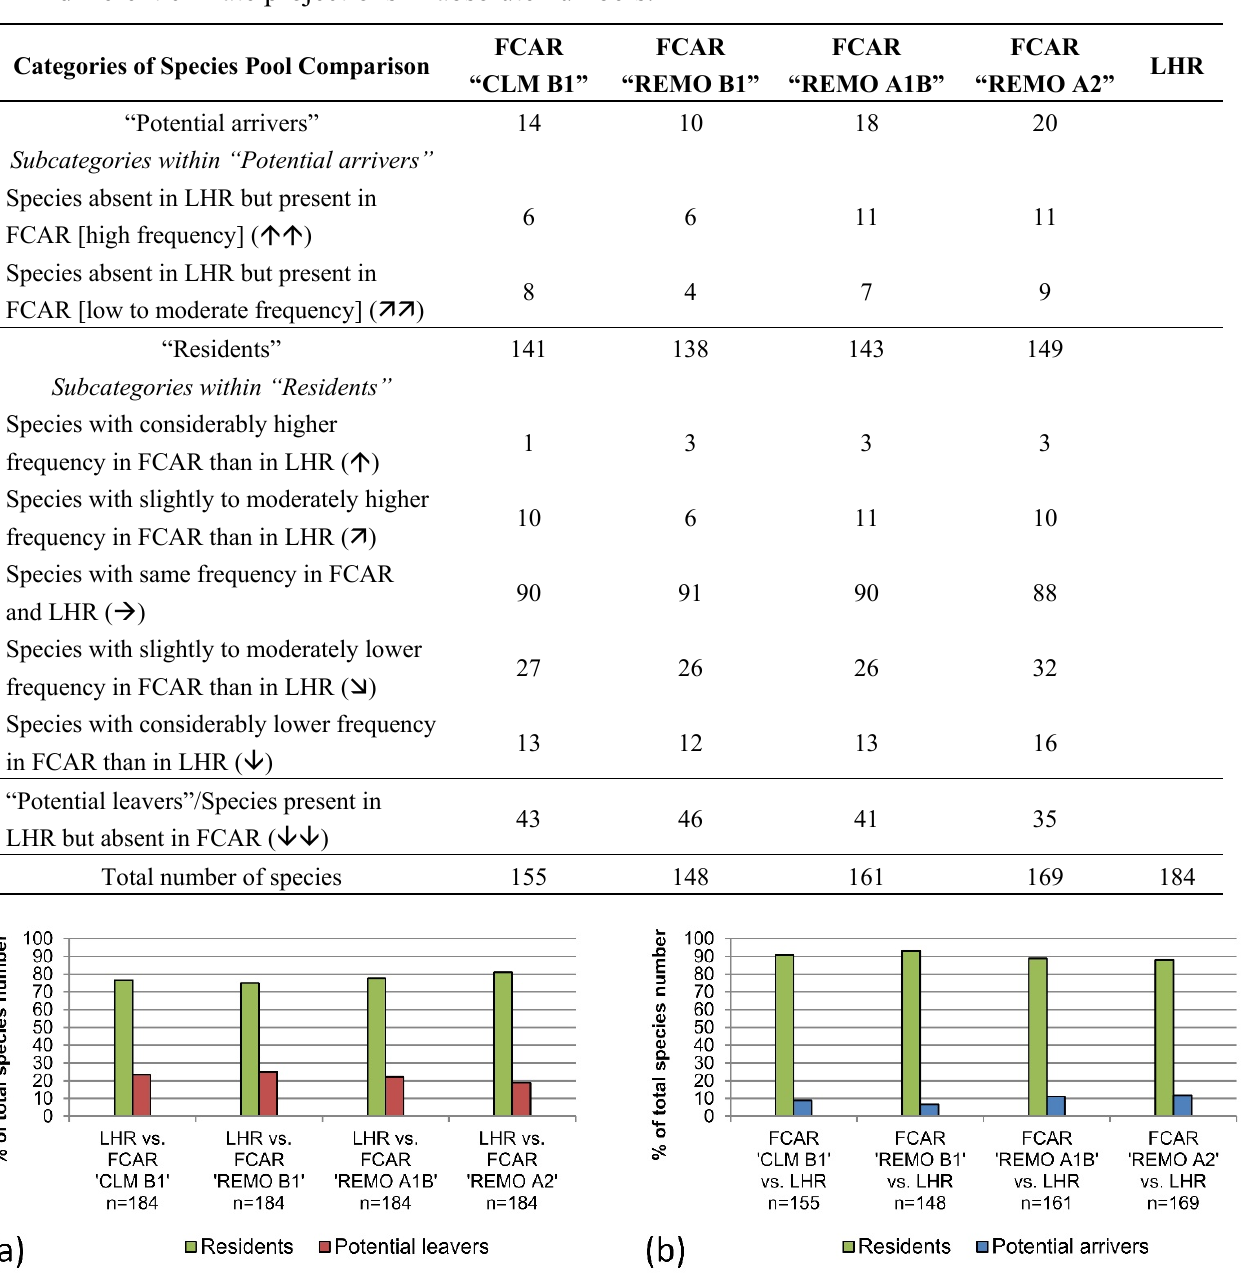
Figure 5. ( a ) Comparison of the species pool of the LHR with the ones of the FCARs; ( b ) Comparison of the species pools of the FCARS with the one of the